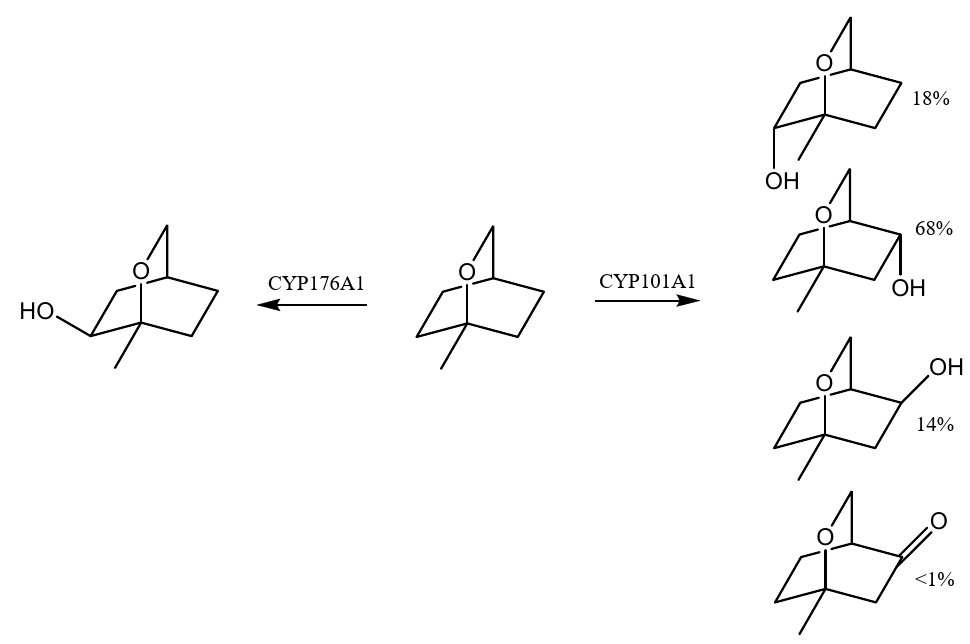
Figure 2. Biotransformation of 1,8-cineole by CYP176A1 and CYP101A1 [105]. Eucalyptol can also be hydroxylated by CYP101A1 from P. putida . This enzyme was